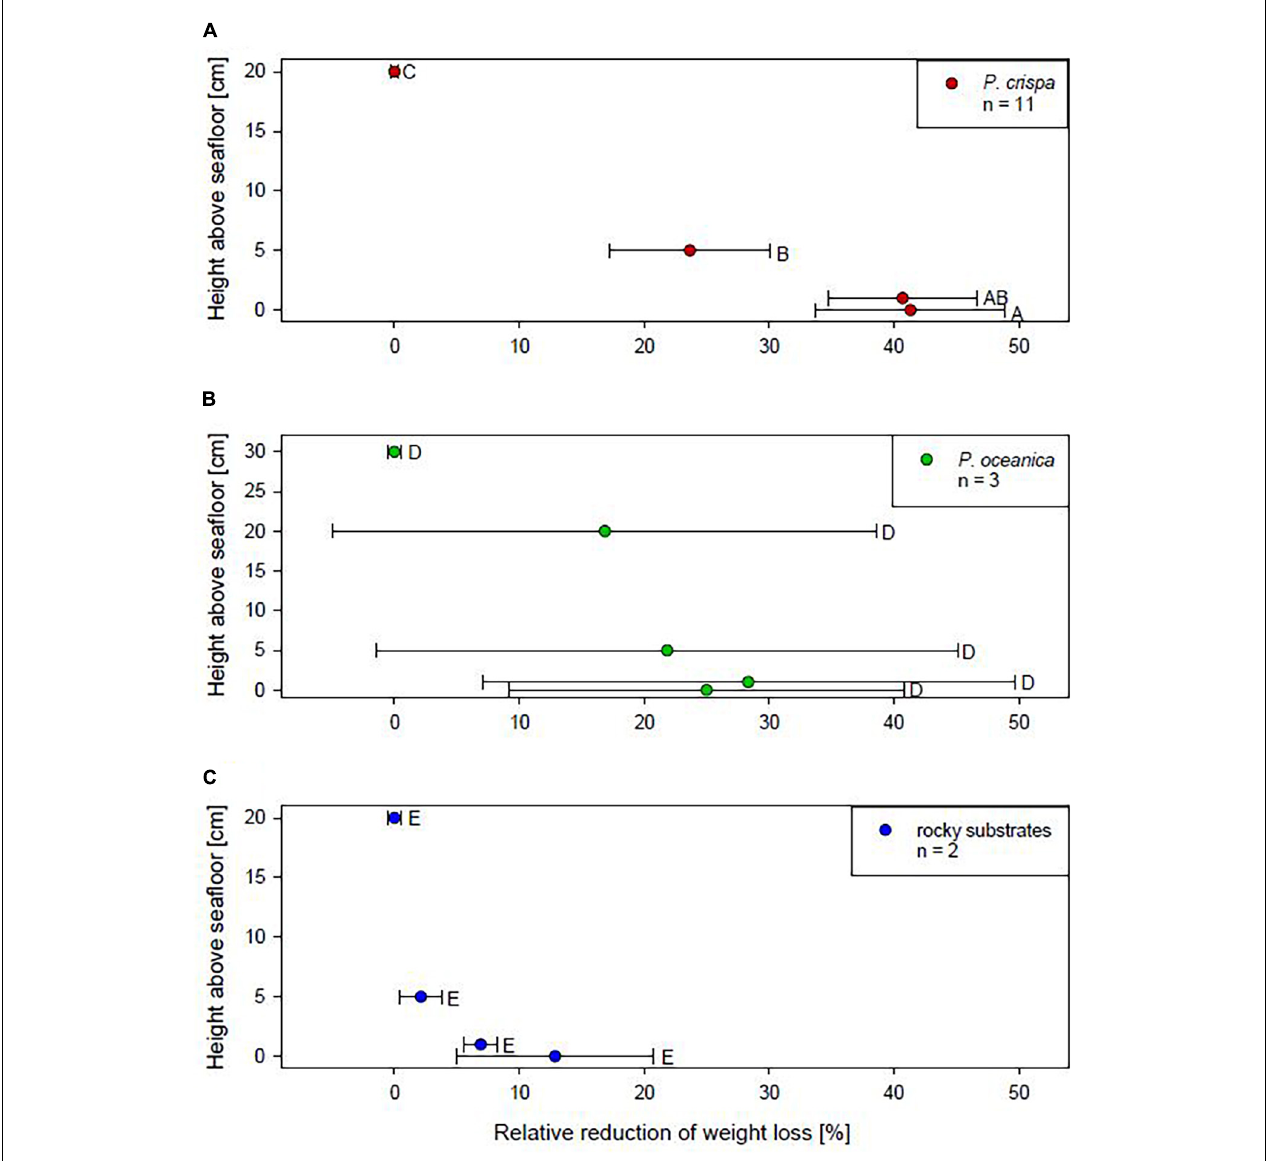
FIGURE 1 | Reduction of daily average weight loss of gypsum balls in Phyllophora crispa (A) , Posidonia oceanica (B) and on rocky substrates (C) relative to the overlaying water (0%). Displayed are mean values and standard error. n = number of rods deployed in situ . No significant differences are indicated by the same letter, significant differences by different